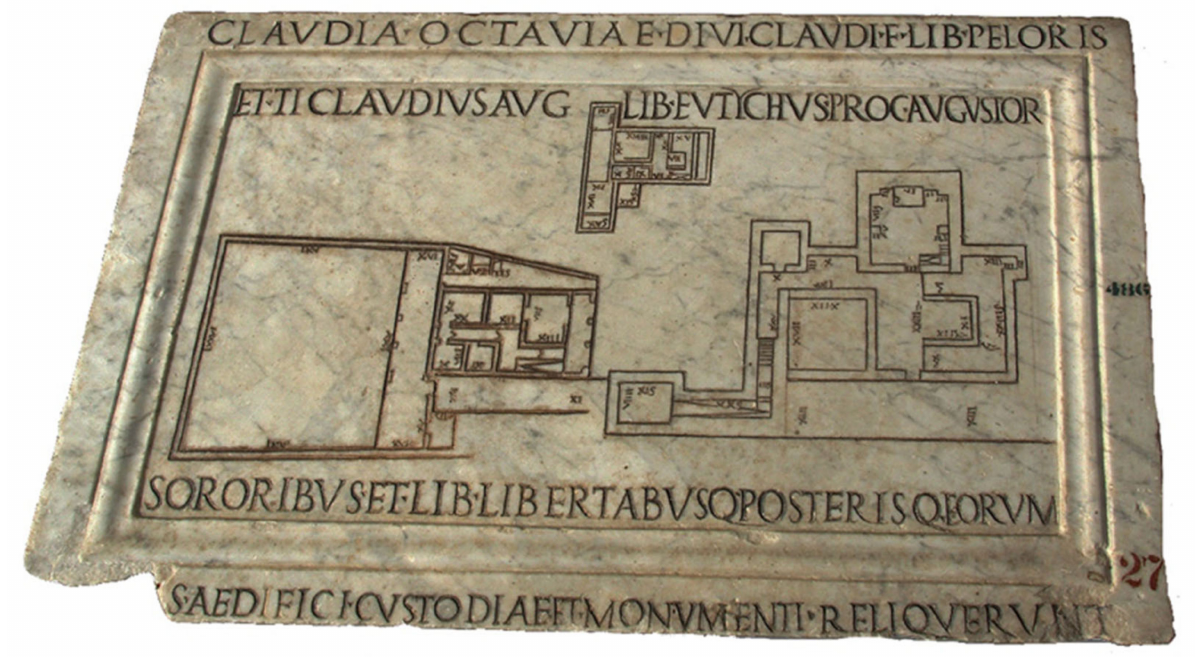
Figure 1. National Archaeological Museum of Perugia, “Marble plan with funerary inscription of a freedwoman and a freedman of Octavia and Nero” Marble 54–68 AC Coll. Gaddi Coll. Oddi, Inv. Com. 486. Rep. n. 45 (CIL VI, 2,